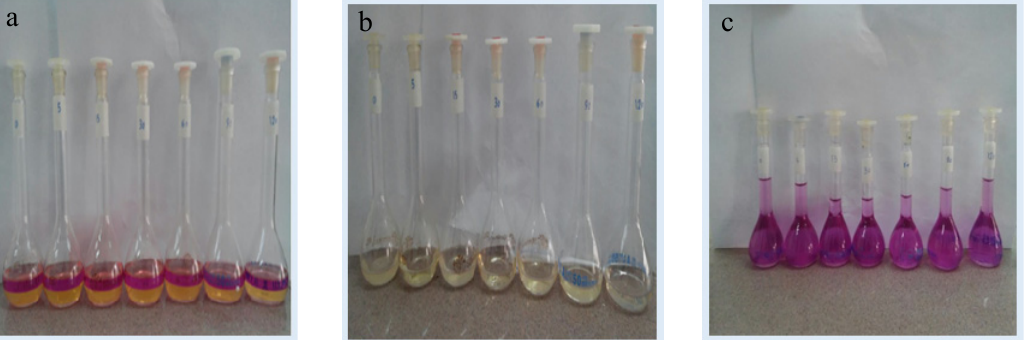
Fig. 2. Spectrophotometric and titrimetric method (a) Flasks removed from the water bath, (b) Flasks extracted from Cyclohexane Fig. 2. spectrophotometric and titrimetric method (a) Flasks removed from the water bath and (c) Flasks volume up at 25 ml by Cyclohexane. , (b) Flasks extracted from Cyclohexane and (c) Flasks volume up at 25 ml by Cyclohexane.